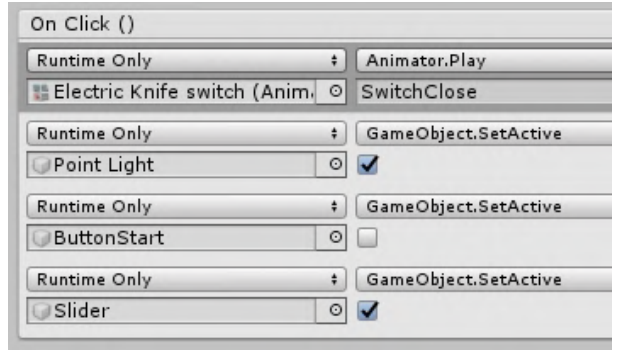
Figure 14: Button settings to close the electric